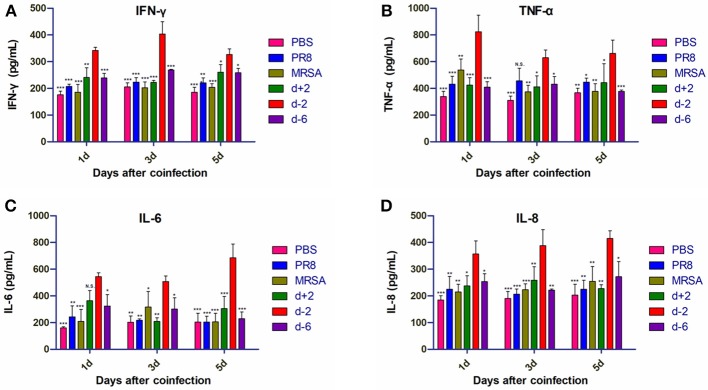
Inflammatory factor levels in the BALF of mice coinfected with influenza virus and methicillin-resistant S. aureus. Levels of (A) IFN-γ, (B) TNF-α, (C) IL-6, and (D) IL-8 in the BALF of coinfected mice are shown at different infection sequences and times. For multiple comparisons, we used one-way analysis of variance with the Tukey post hoc test. Data are represented as mean ± standard error of the mean. (N.S., not significant; *p < 0.05; **p < 0.01; ***p < 0.001, n = 6). BALF, bronchioalveolar lavage fluid; PR8, influenza A virus strain; MRSA, methicillin-resistant S. aureus; PBS, phosphate-buffered saline. IFN, interferon; TNF, tumor necrosis factor; IL, interleukin.